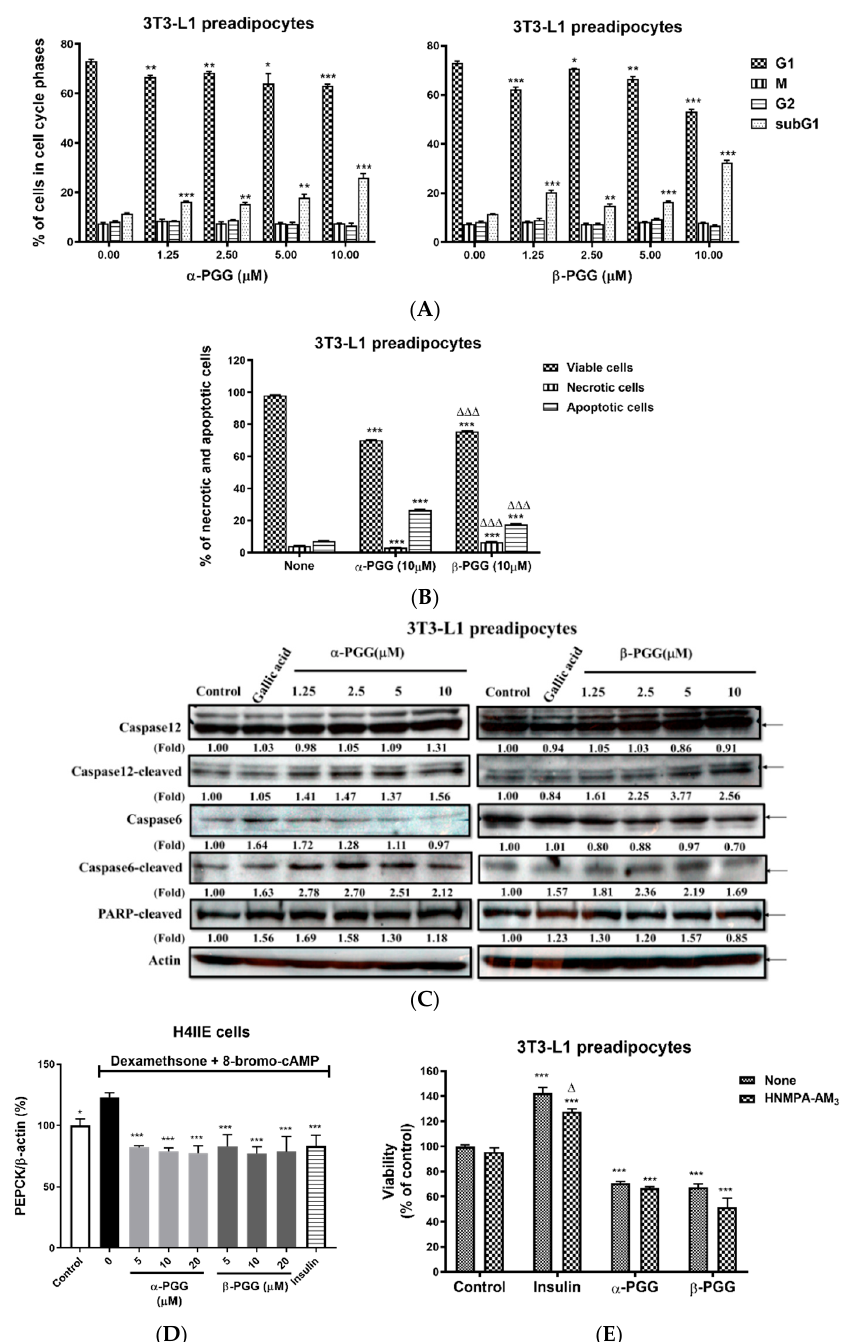
Figure 2. The induction of pre-adipocyte cell death by PGG is independent from its insulin mimetic action. 3T3-L1 pre-adipocyte was treated with α - and β -PGG and evaluated for ( A ) cell cycle analysis, ( B ) annexin-V (AV) and propidium iodide (PI) staining ( n = 3), and ( C ) apoptosis-related protein biomarkers. The biological activity of PGG to suppress ( D ) phosphoenopyruvate carboxykinase (PEPCK; n = 3) mRNA expression and to reduce ( E ) cell viability with or without HNMPA-AM 3 ( n = 4) were also measured. Data are shown as mean ± SEM.* p < 0.05, ** p < 0.01, and *** p < 0.001 compared to control (vehicle). ∆ p < 0.05 and ∆∆∆ p < 0.001 compared with corresponding α -PGG group or non-HNMPA-AM 3